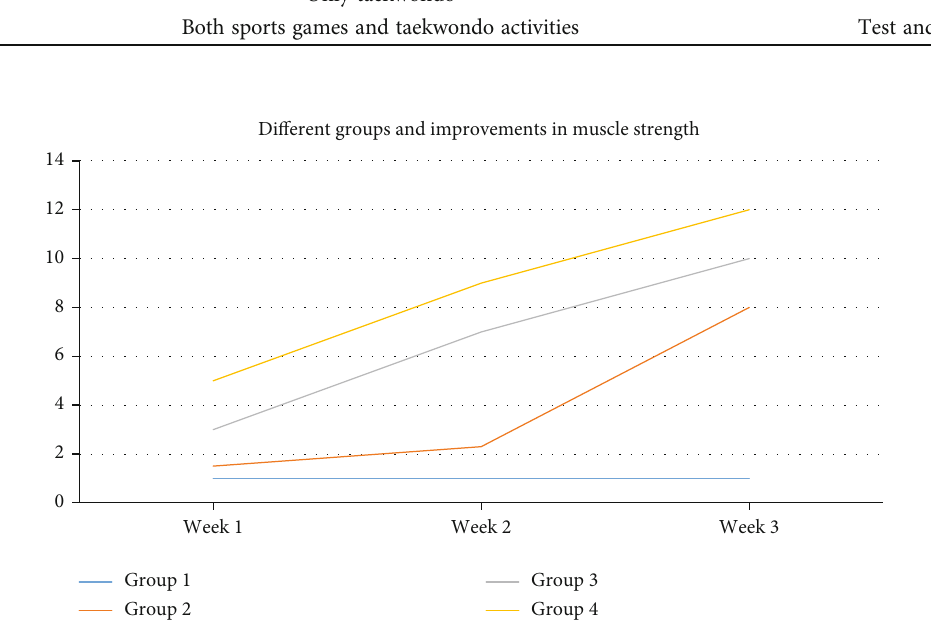
Figure 2: Broken line diagram of three test groups during physical fi tness test. The fi gure shows that the test curve value of group 4 combined with sports competition and taekwondo activities is increasing compared with other groups. This is because the integrated application of sports and taekwondo in colleges and universities can improve muscle strength and signi fi cantly improve students ’ overall physical fi tness. On the other hand, the muscle strength of the fi rst group of participants engaged in only one activity did not change during the Table 3: Results on aerobic Queen ’ s test.